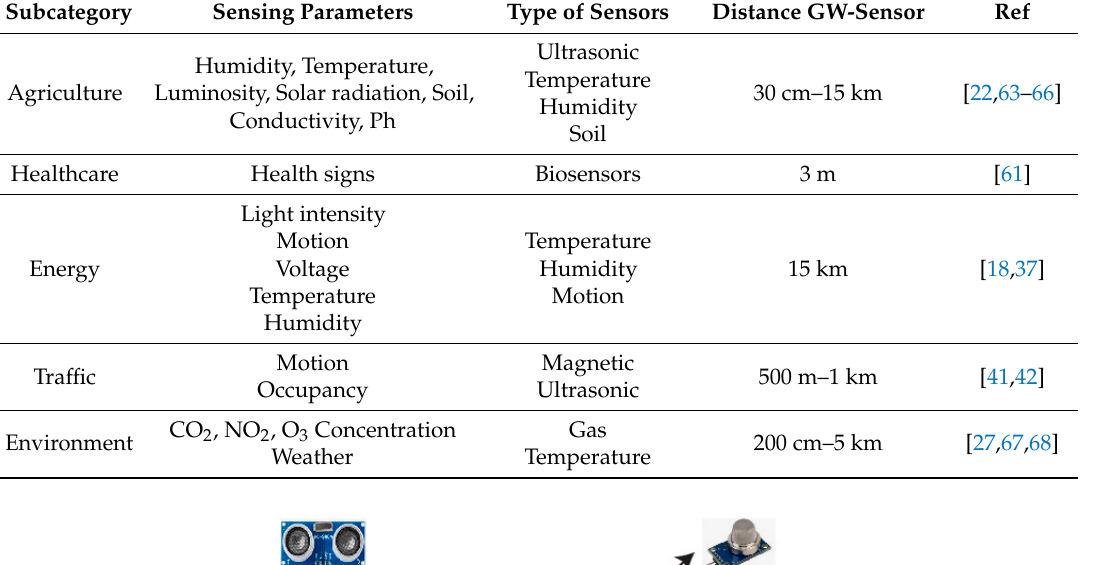
Table 9. Types of sensors used in di ff erent subcategories of smart city applications.